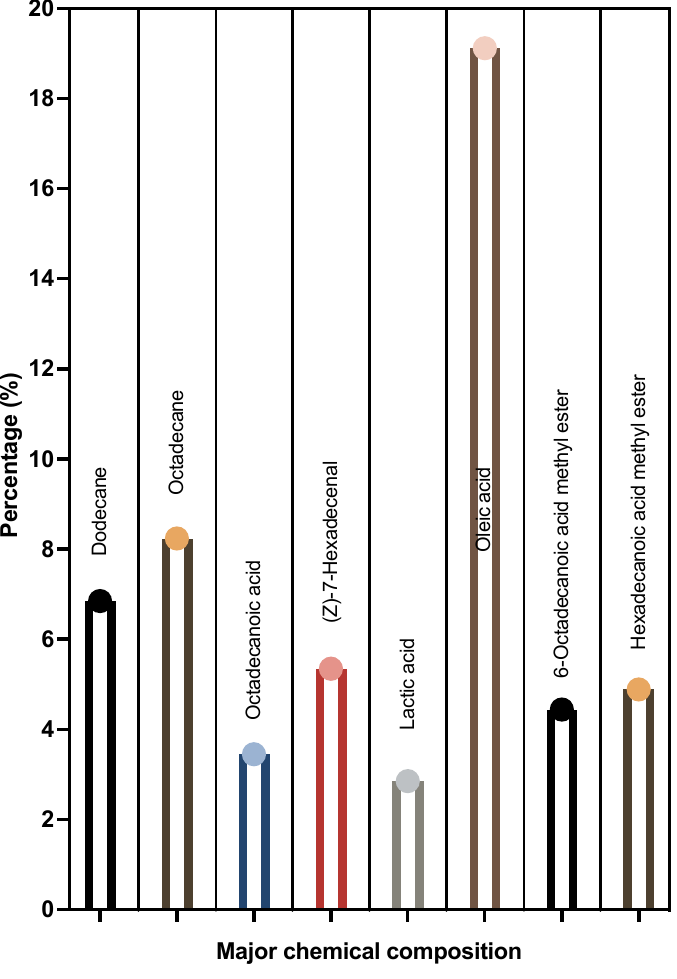
Figure 7. Major composition of the metabolites obtained from LME.